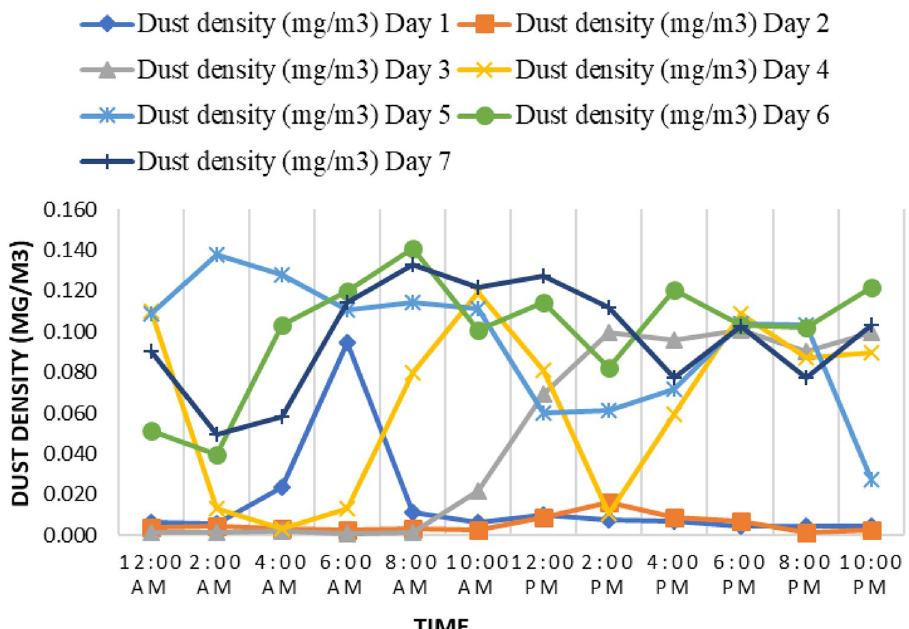
Fig. 2 Dust density analysis for 7 days at UTHM, Johor,